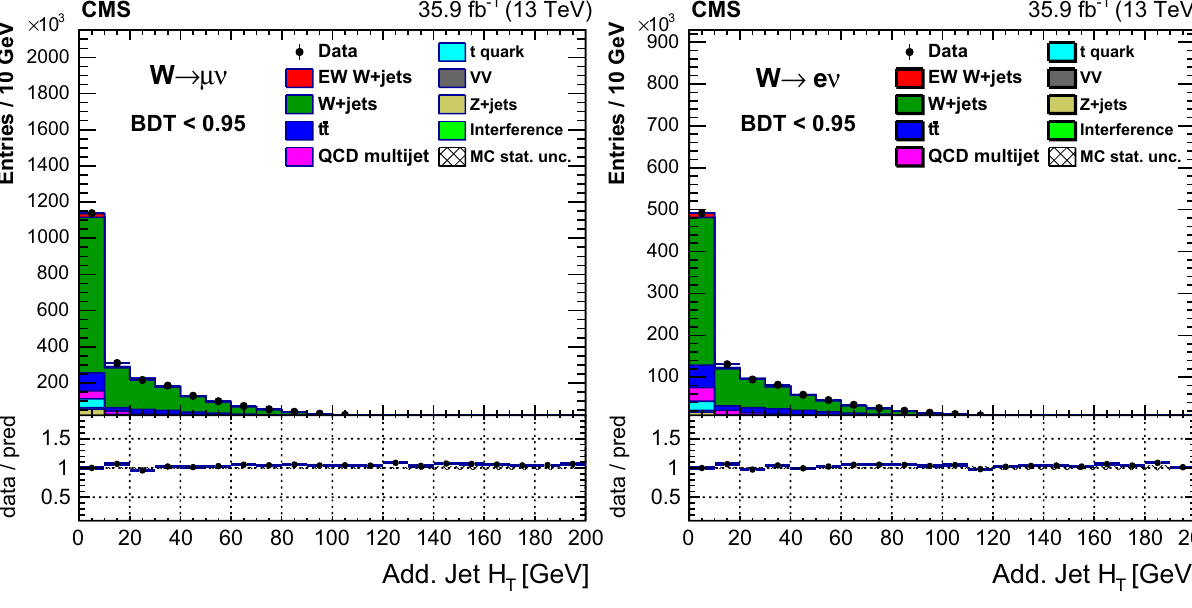
Fig. 24 Total H T of the additional jets for BDT < 0 . 95 in the muon (left) and electron (right) channels. In all plots the fist bin contains events where no additional jet with p T > 15GeV is